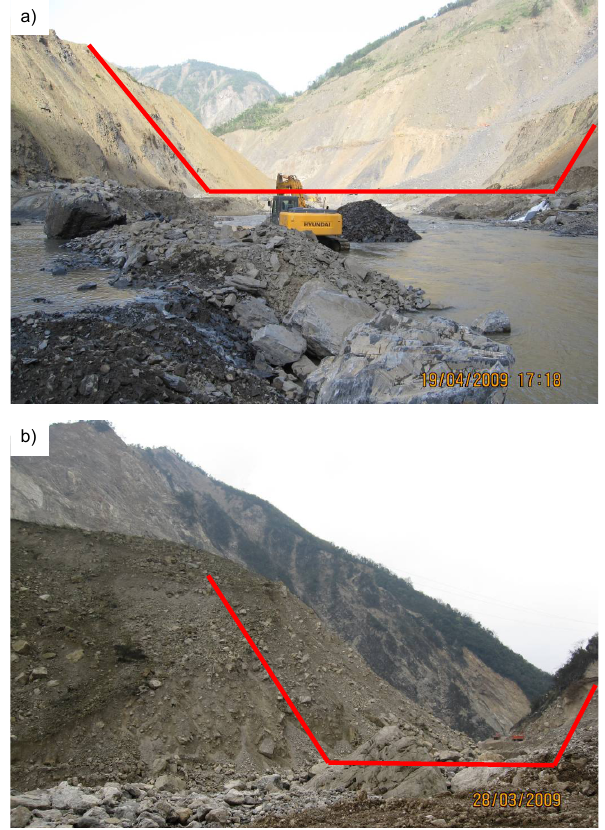
Fig. 5. The two landslide dams after breaching. ( a ) Tangjiashan Landslide Dam; ( b ) Xiaogangjian Landslide Dam.